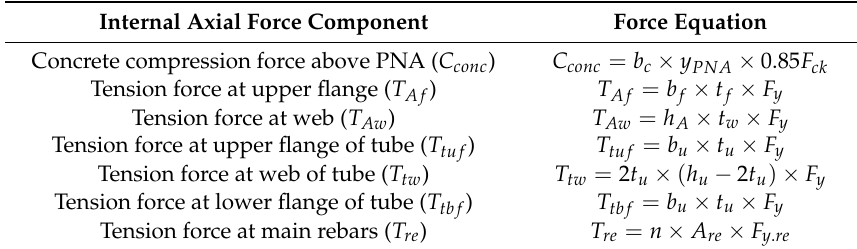
Table 7. Internal force components in case the plastic neutral axis exists above the upper flange.